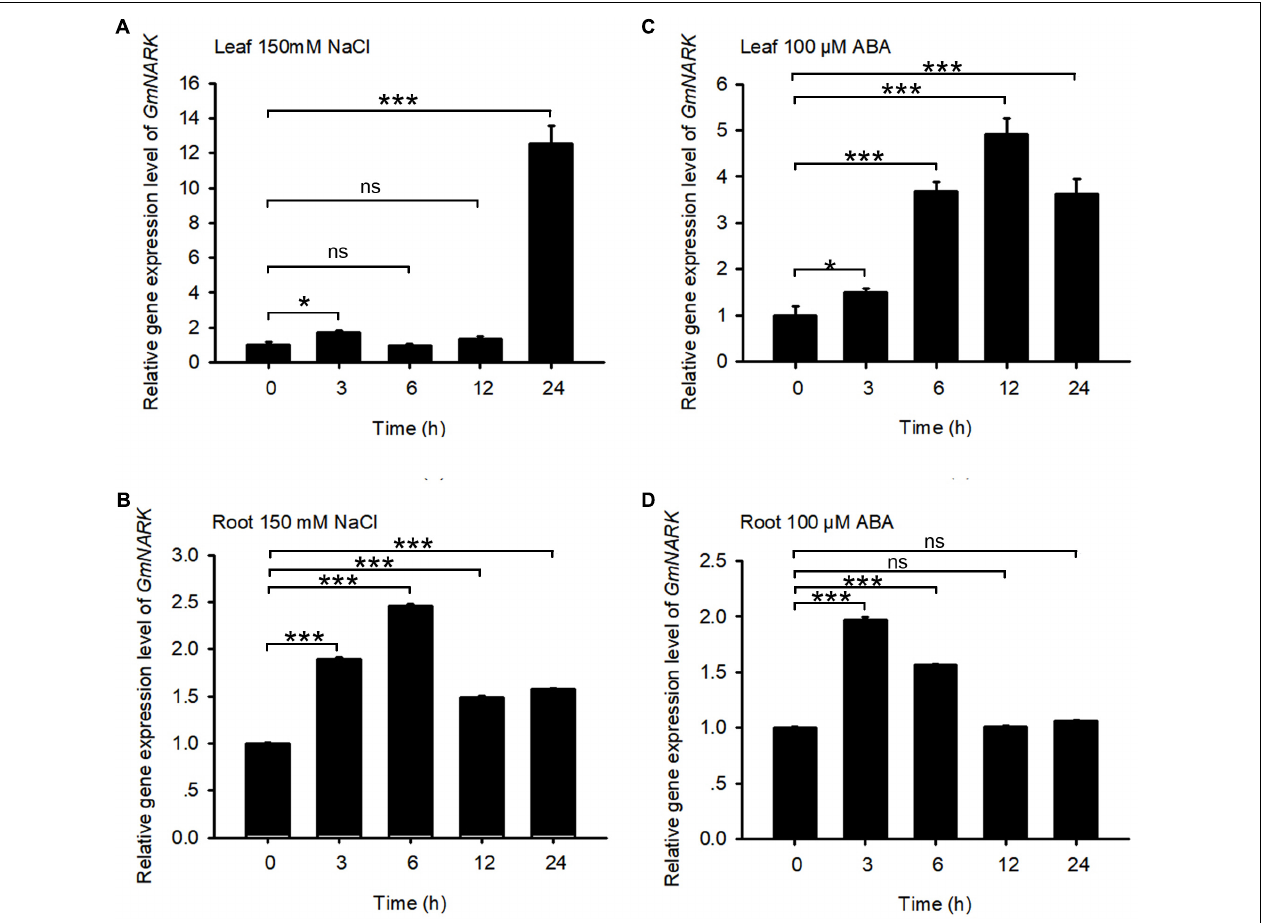
FIGURE 3 | Expression Pattern of GmNARK. (A,B) GmNARK expression assay in response to NaCl in shoot and root by quantitative real-time PCR. Total RNA was extracted from 7-day-old wild-type soybean seedlings treated with 150 mM NaCl at the indicated time points. GmELF was used as an internal control. The values are means ± standard error. The Student’s t -test was performed and the statically significant treatments were marked with ‘ ∗∗∗ ’ ( P < 0.001), ‘ ∗ ’ ( P < 0.05) and ‘ns’ (no significance). Three independent biological repeats were performed. (C,D) GmNARK expression assay in response to ABA in shoot and root by quantitative real-time PCR. Total RNA was extracted from 7-day-old wild-type soybean seedlings treated with 100 µ M ABA at the indicated time points. GmELF was used as an internal control. The values are means ± standard error. The Student’s t -test was performed and the statically significant treatments were marked with ‘ ∗∗∗ ’ ( P < 0.001), ‘ ∗ ’ ( P < 0.05) and ‘ns’ (no significance). Three independent biological repeats were